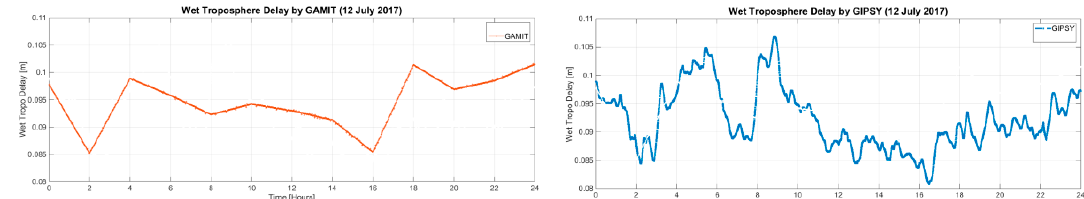
Figure 15. An example, of the Zenith Wet Troposphere Delay in mm as derived by GNSS processing with GAMIT ( left ) and GIPSY ( right ) scientific software for 12 July 2017 at the transponder CDN1 Cal/Val site.